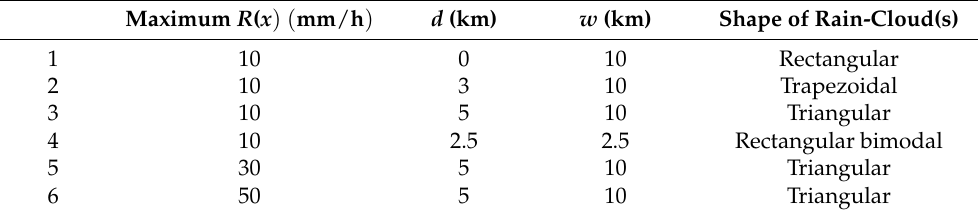
Figure 7. Triangular distribution diagrams for 𝑅(𝑥) = 50 mm/h . ( a ) Given precipitation distribu- tion; ( b ) Simulated precipitation distribution; ( c ) Given precipitation distribution and simulated precipitation distribution; ( d ) Relative error between given and simulated results. Table 2. The attributes of the 6 examples.